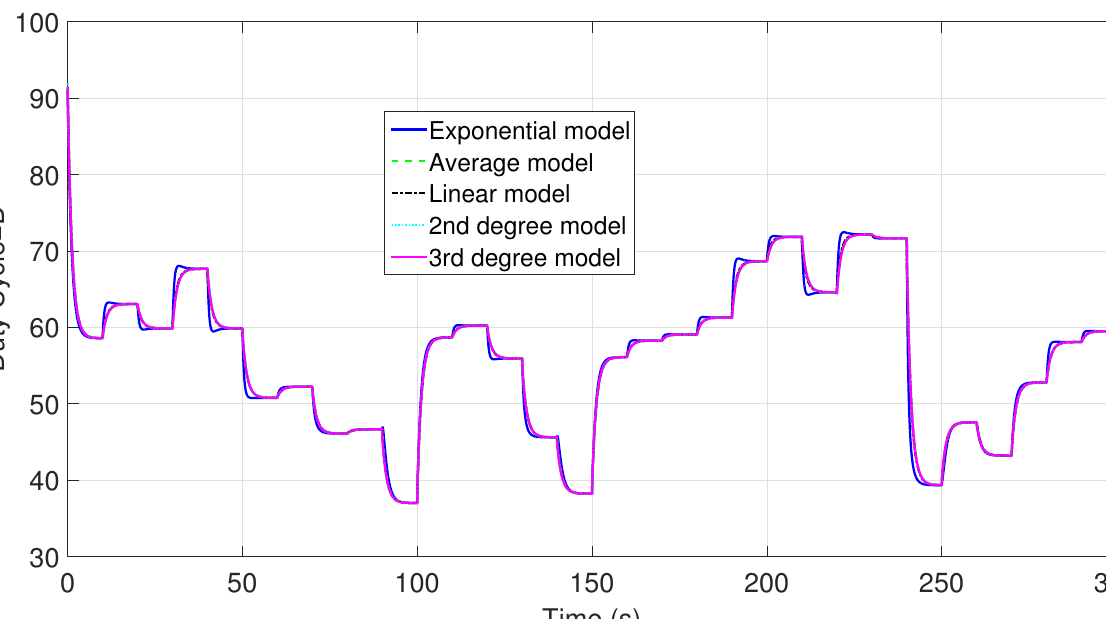
Figure 8. Rotor speed control and tracking from 190 to 230 s.